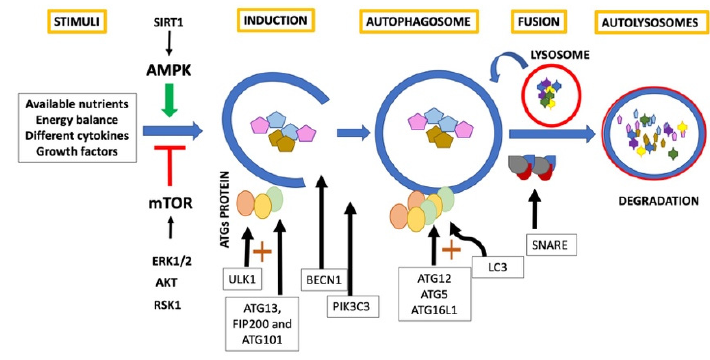
Figure 1. Classic